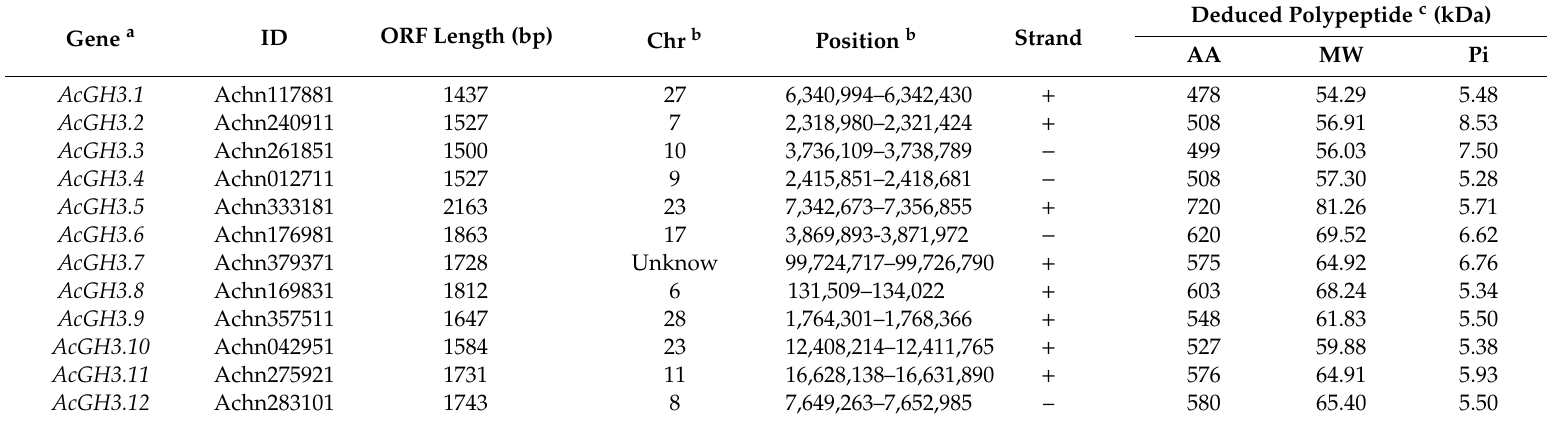
Table 1. The GH3 gene family in kiwifruit.